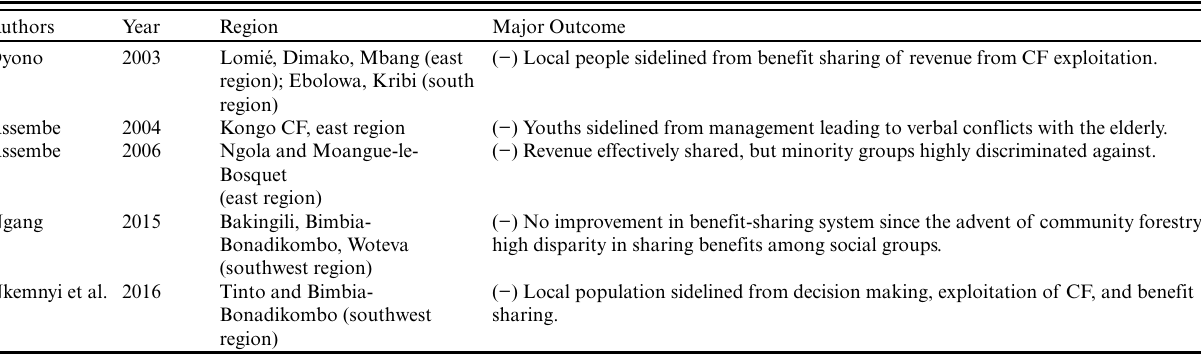
Table 5 . Equity in community forest (CF)